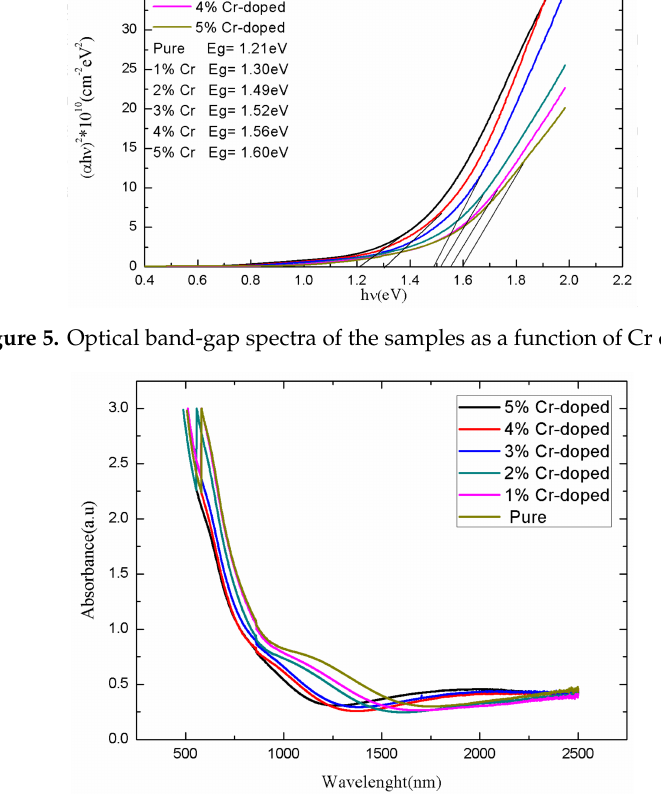
Figure 6. Absorbance spectra of the pure and Cr-doped PbS